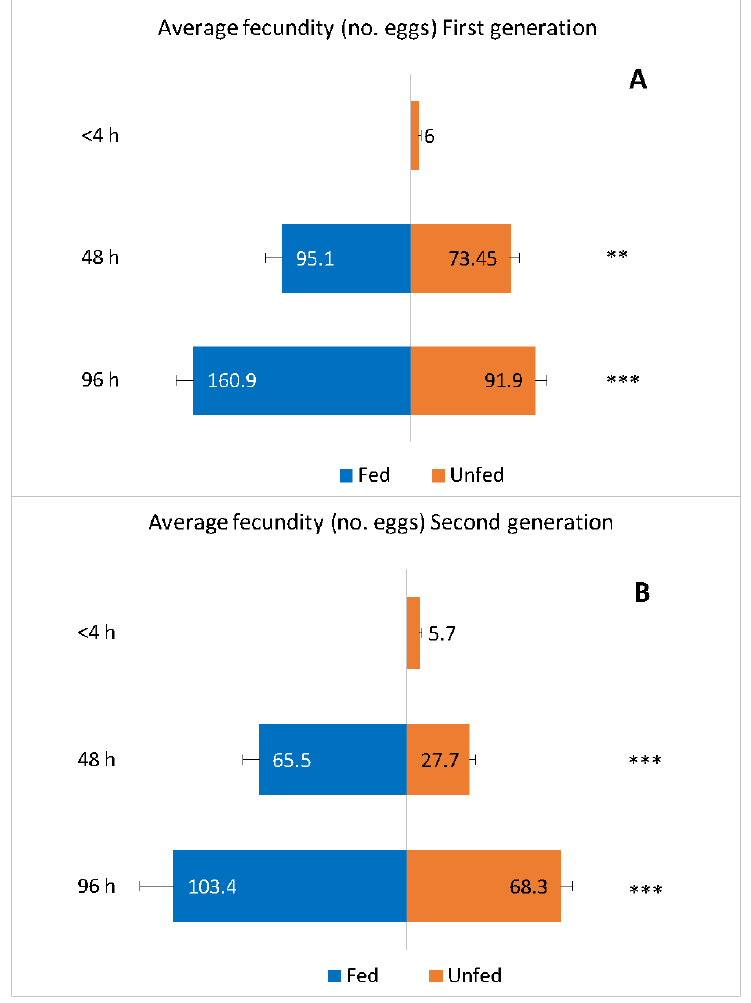
Figure 2. Mean number ( ± SE) of mature eggs in Cydalima perspectalis according to age cohort (<4, 48, 96 h), availability of food (red bar = unfed females; blue bar = honey-fed females), and generation ( A = first generation; B = second generation). Line bars represent standard error of the mean. Sample size for each age cohort = 10. The asterisks indicate significant difference (**, p < 0.01; ***, p < 0.001) between bars, according to the paired t